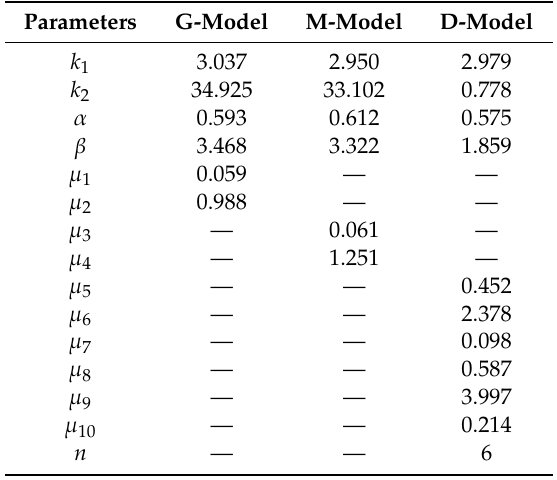
Table 1. Parameter identification results for ISSF-Duhem model with three shape functions under 1 Hz harmonic input with di ff erent currents. G-Model: the ISSF-Duhem model with Grompertz function-based shape function; M-Model: the ISSF-Duhem model with modified hyperbolic tangent function-based shape function; D-Model: the ISSF-Duhem model with a one-sided dead-zone operator-based shape